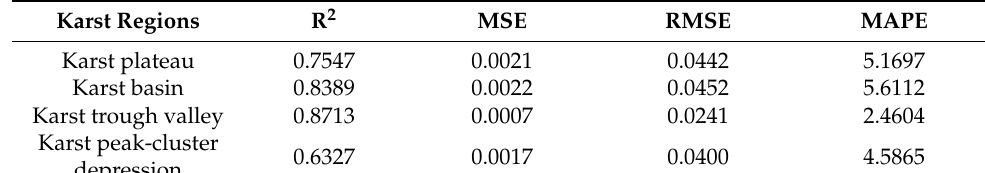
Table 1. The prediction accuracy of the BPNN model.